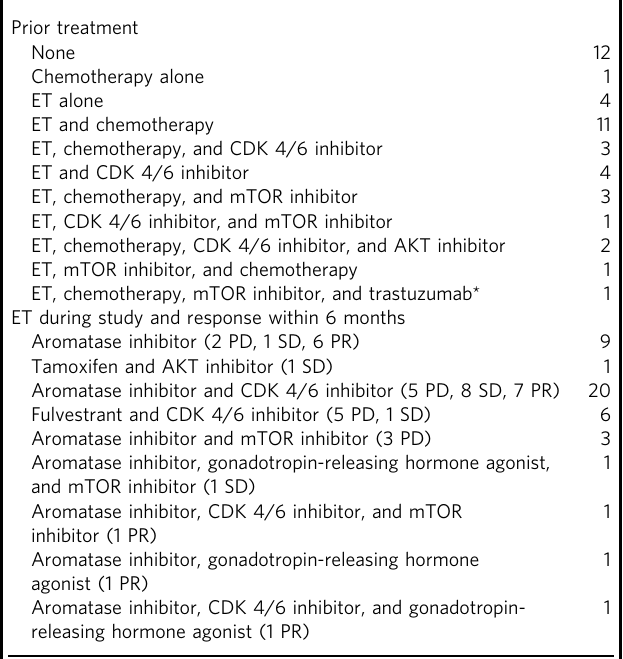
Table 2 Treatment summary. Prior treatment